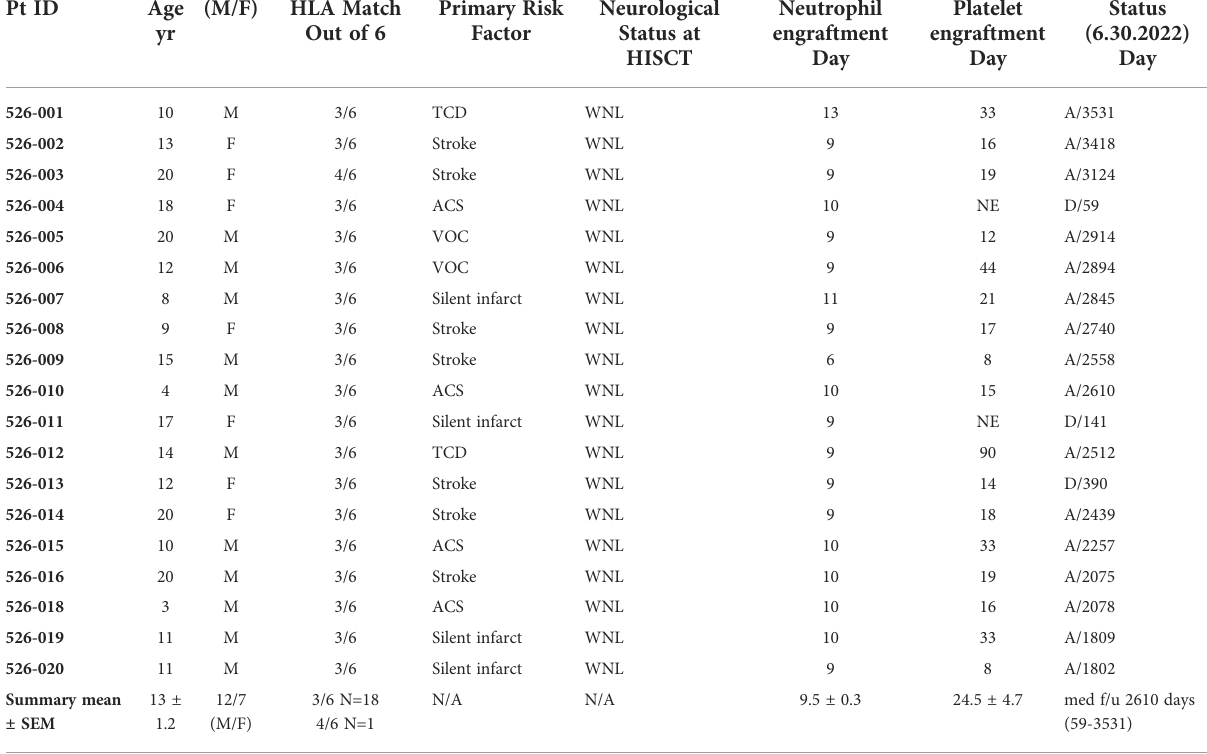
TABLE 1 Clinical characteristics and clinical outcome results of HISCT recipients (N =